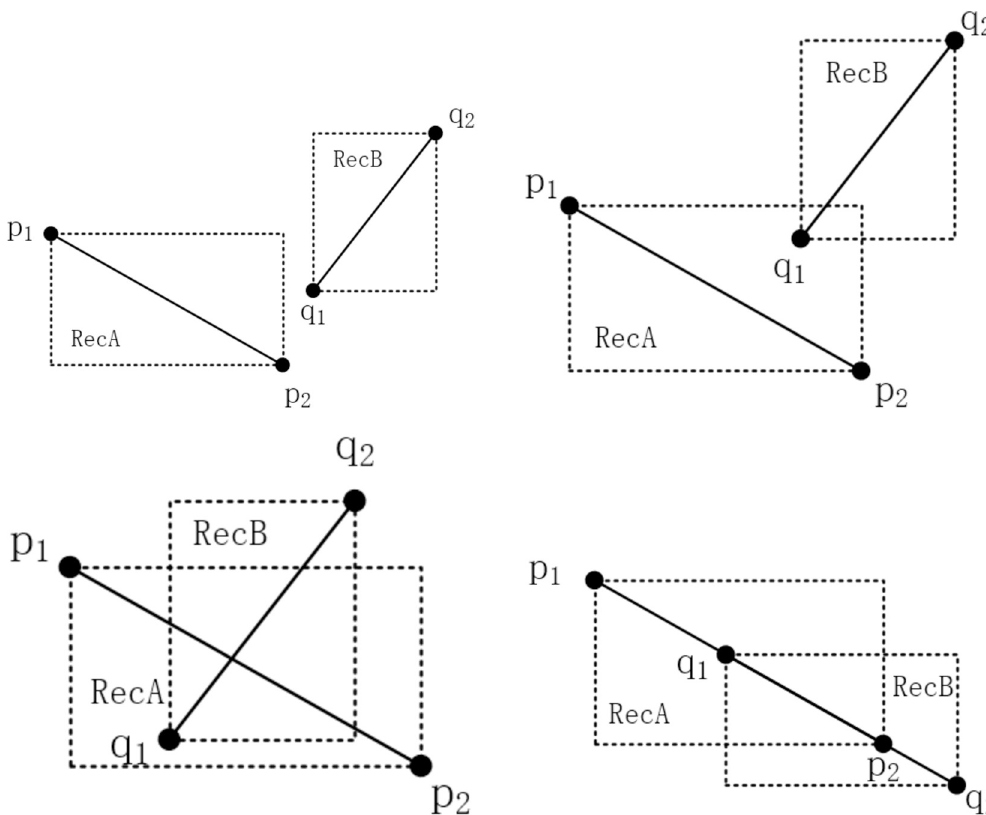
Fig 3. Intersection solving of two line segments.